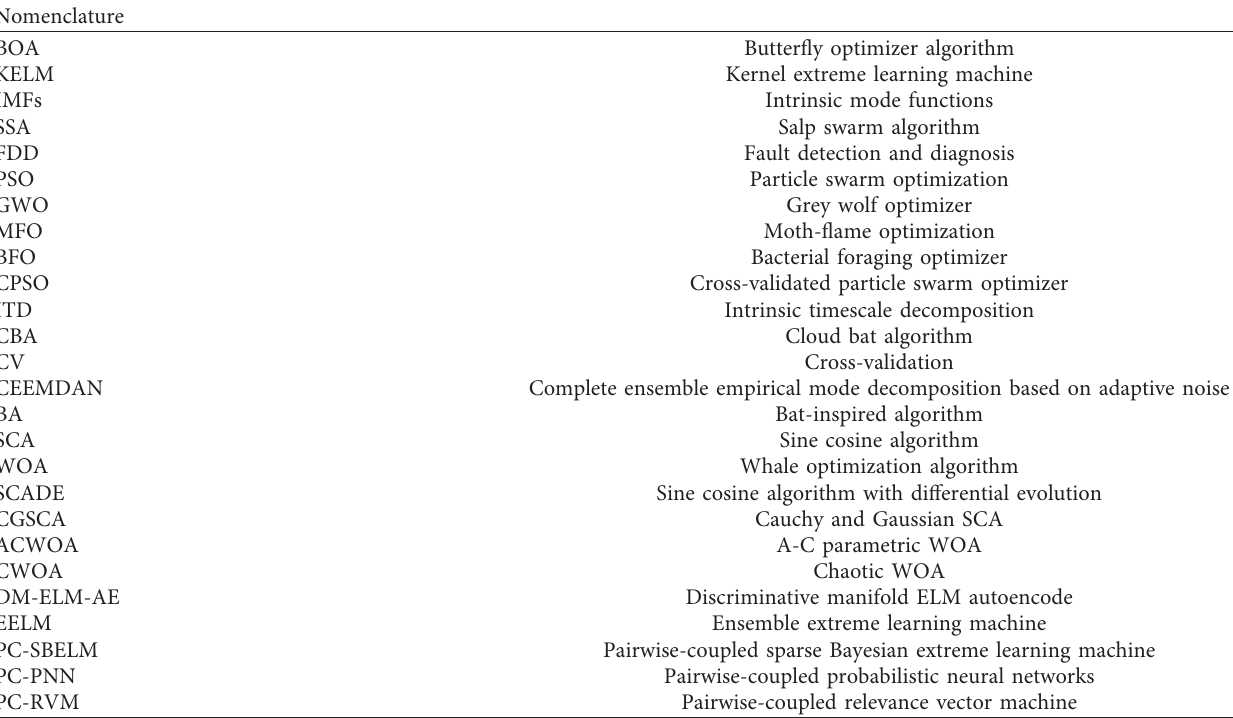
Table 1: Nomenclatures in the